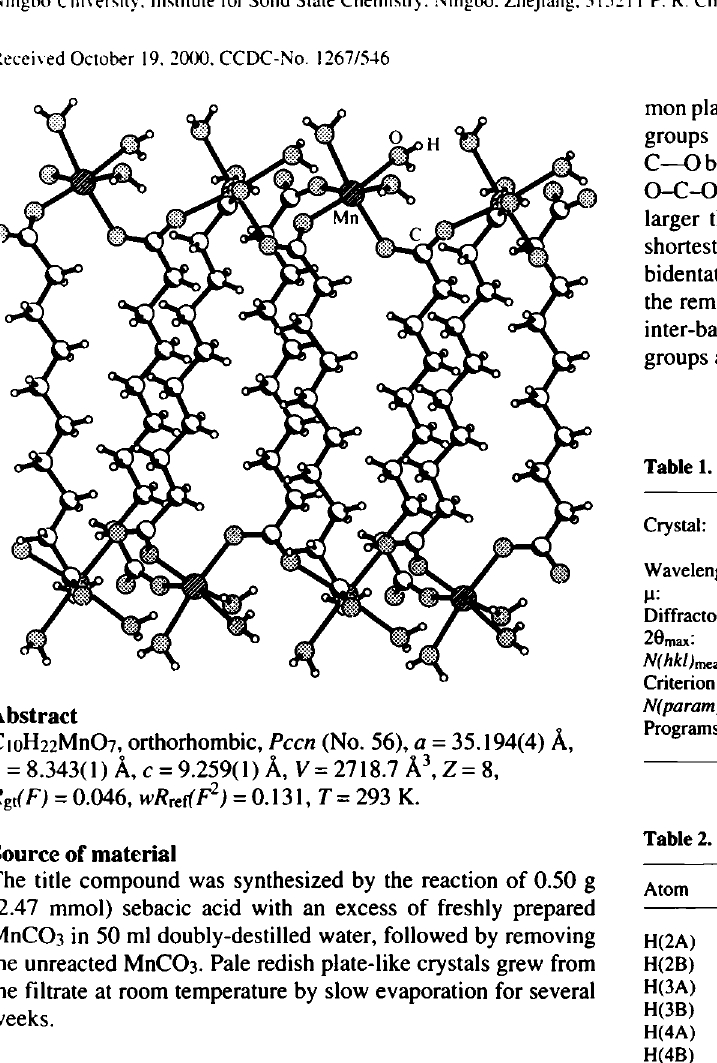
Table 2. Atomic coordinates and displacement parameters (in A 2